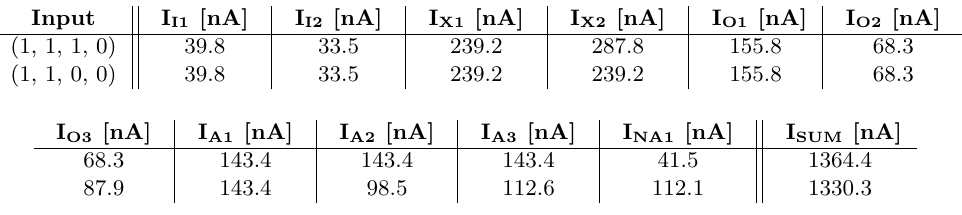
Table 6: Leakage currents exhibited by all circuit gates for the stable inputs before and after the input